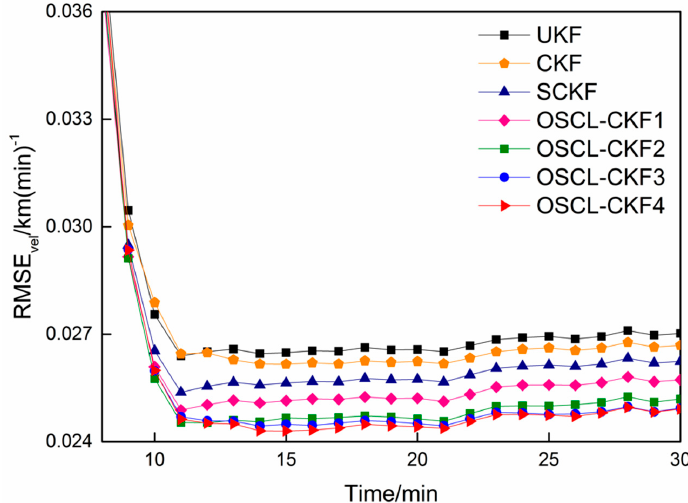
Figure 4. The velocity RMSE of various algorithms.